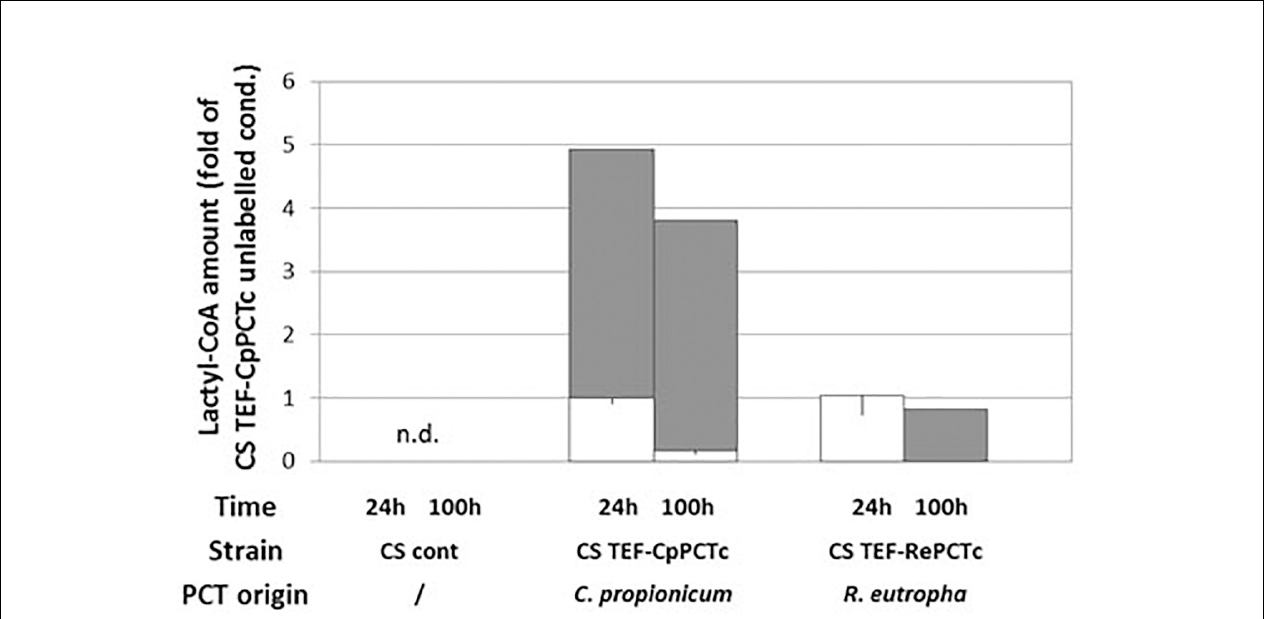
FIGURE 2 | Quantification of D - and L -lactyl-CoA produced in strain expressing PCT protein from different organisms. Strains were grown for 24 h and 100 h on minimum medium containing a mixture of 5 g/L of unlabeled L -lactic acid and 5 g/L of labeled D -lactic acid 3- 13 C. After a normalization, results were expressed as fold of CS + TEF-CpPCTc strain unlabeled result at 24 h. White bars: unlabeled compound, gray bars: 13 C-labeled compound. For clarity purposes, only half error bars have been represented; to the bottom for unlabeled compound and to the top for labeled one. N = 3 independent experiments. n.d., not